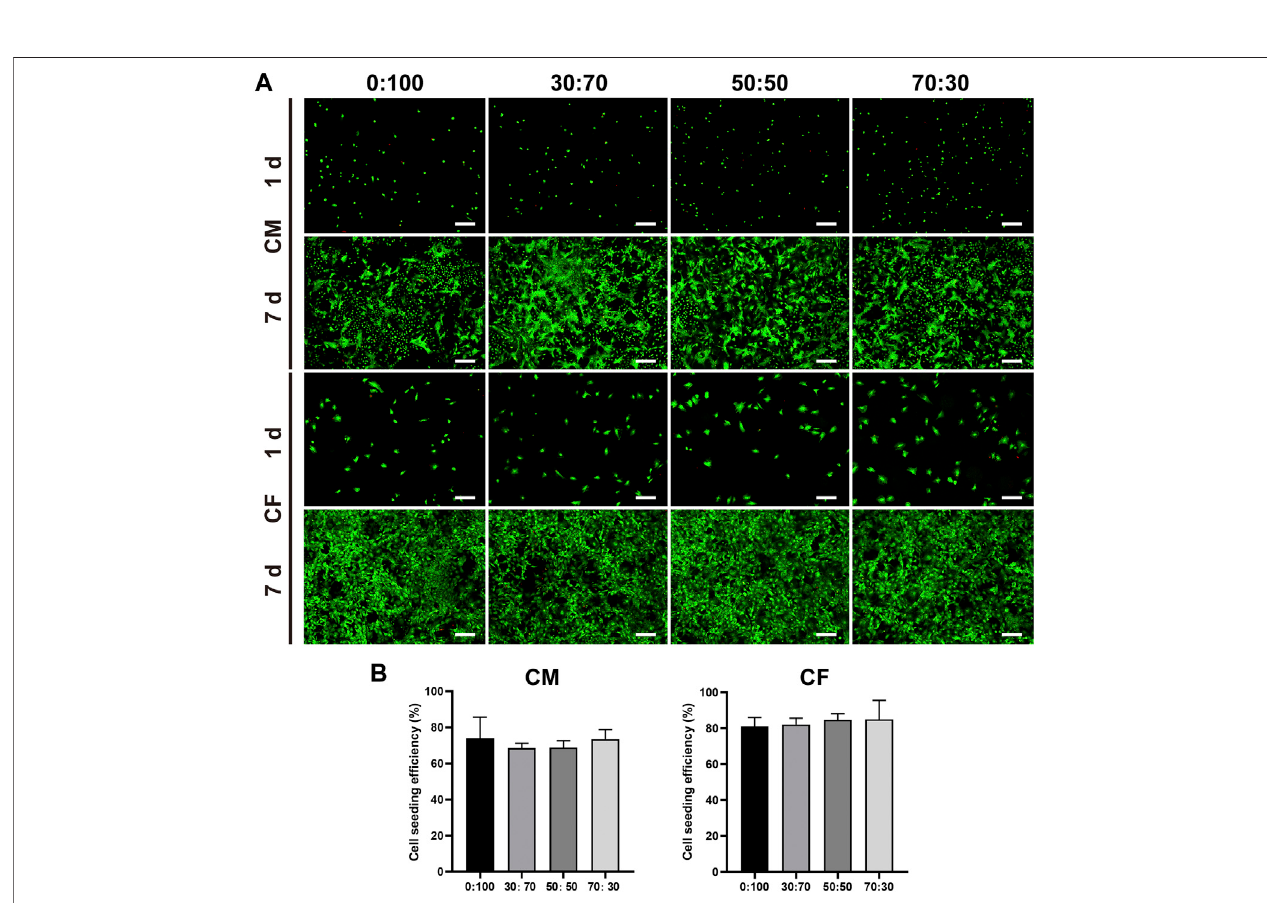
FIGURE4|(A) Representativeliveanddeadstainingimagesofcardiomyocytesandcardiac fi broblastsculturedondifferentmembranesforoneand7 days.Scale bars (cid:1) 200 μ m. (B) Seeding ef fi ciencies of cardiomyocytes and cardiac fi broblasts on different membranes.